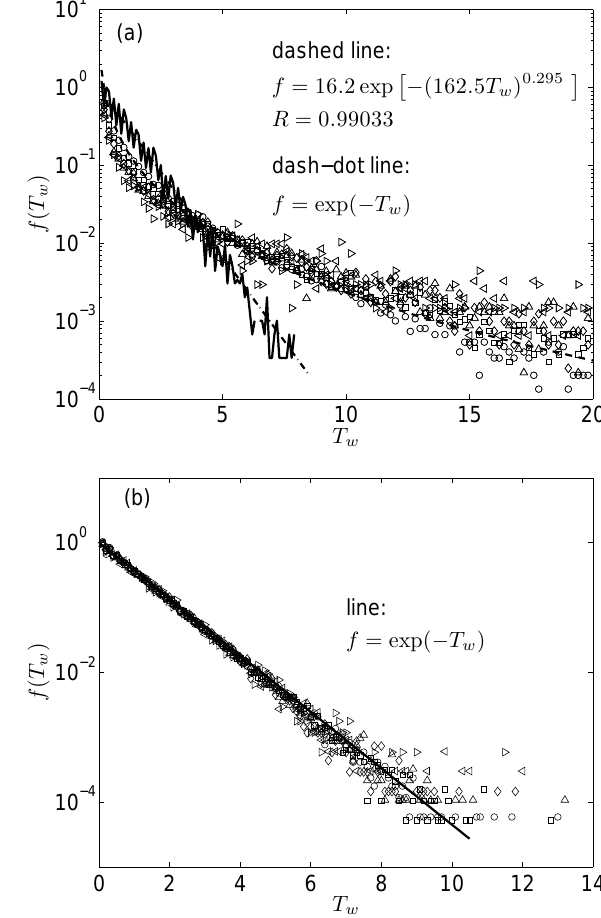
Fig. 6. (a) Comparison of PDFs of artificial independent time series and the truncated stable distribution with the same parameters in Figure 3a. (b) Artificial independent time series (top) and extracted extreme fluctuations (bottom). Thresholds are denoted by dashed lines in the top plot.